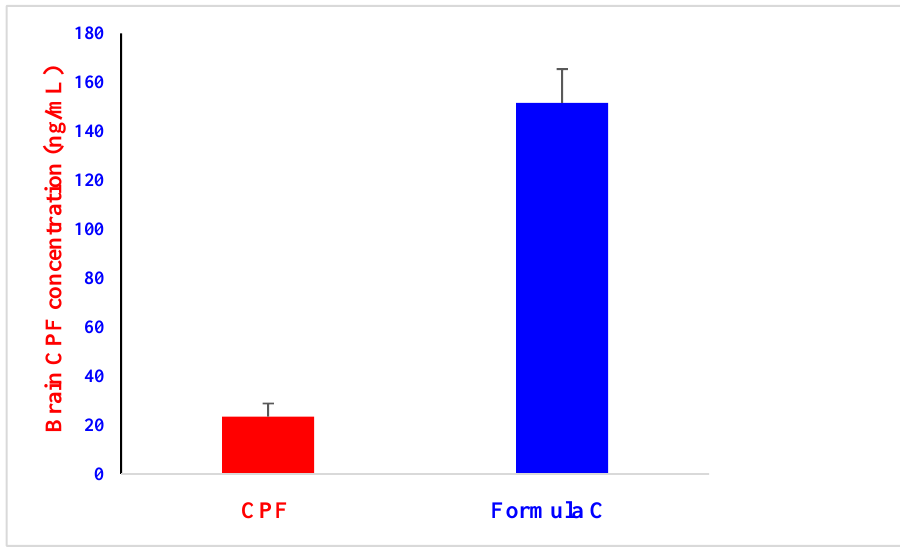
Figure 6. Distribution of CPF (1 mg/kg) in the brain at 15 min after intranasal administration of CPF solution and formula C to rats. Each data value represents the mean ± SEM of n = 3.